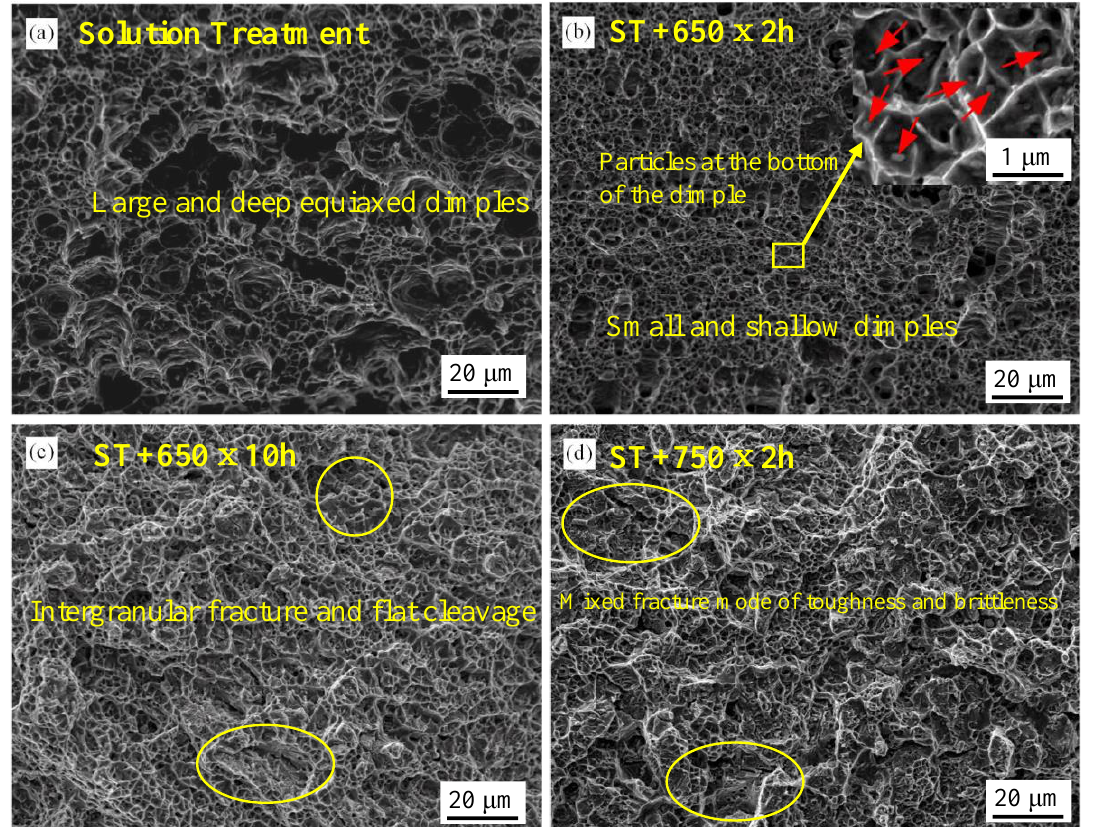
Figure 12. Fracture morphology of tensile specimens after different aging treatment. ( a ) Solution treatment, ( b ) aging at 650 °C with 2 h after solution treatment, the precipitates at the bottom of the dimple are indicated by red arrows, ( c ) aging at 650 °C with 10h after solution treatment, cleavage fracture is marked by yellow circle, ( d ) aging at 750 °C with 2 h after solution treatment, intergranular fracture is marked by yellow circle.